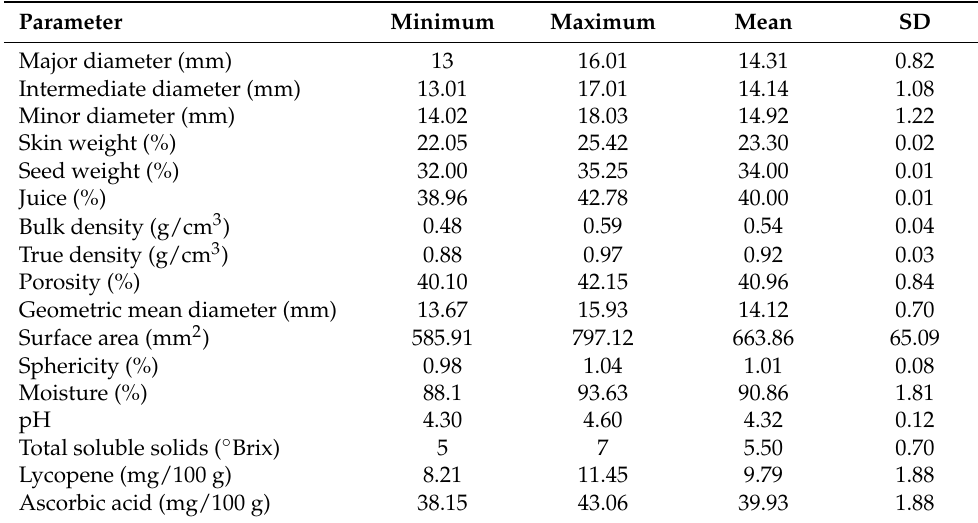
Table 1. Descriptive statistics for the physicochemical characteristics of currant tomato 1